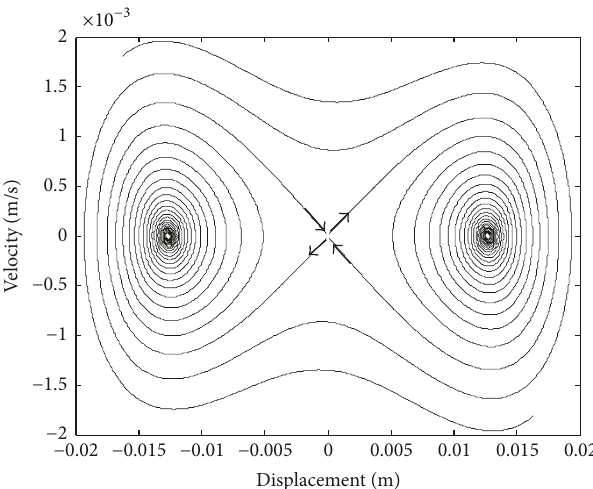
Figure 7: Numerical simulation for region (V), for ( 𝐾 1 , 𝐾 2 ) = ( − 0.02,